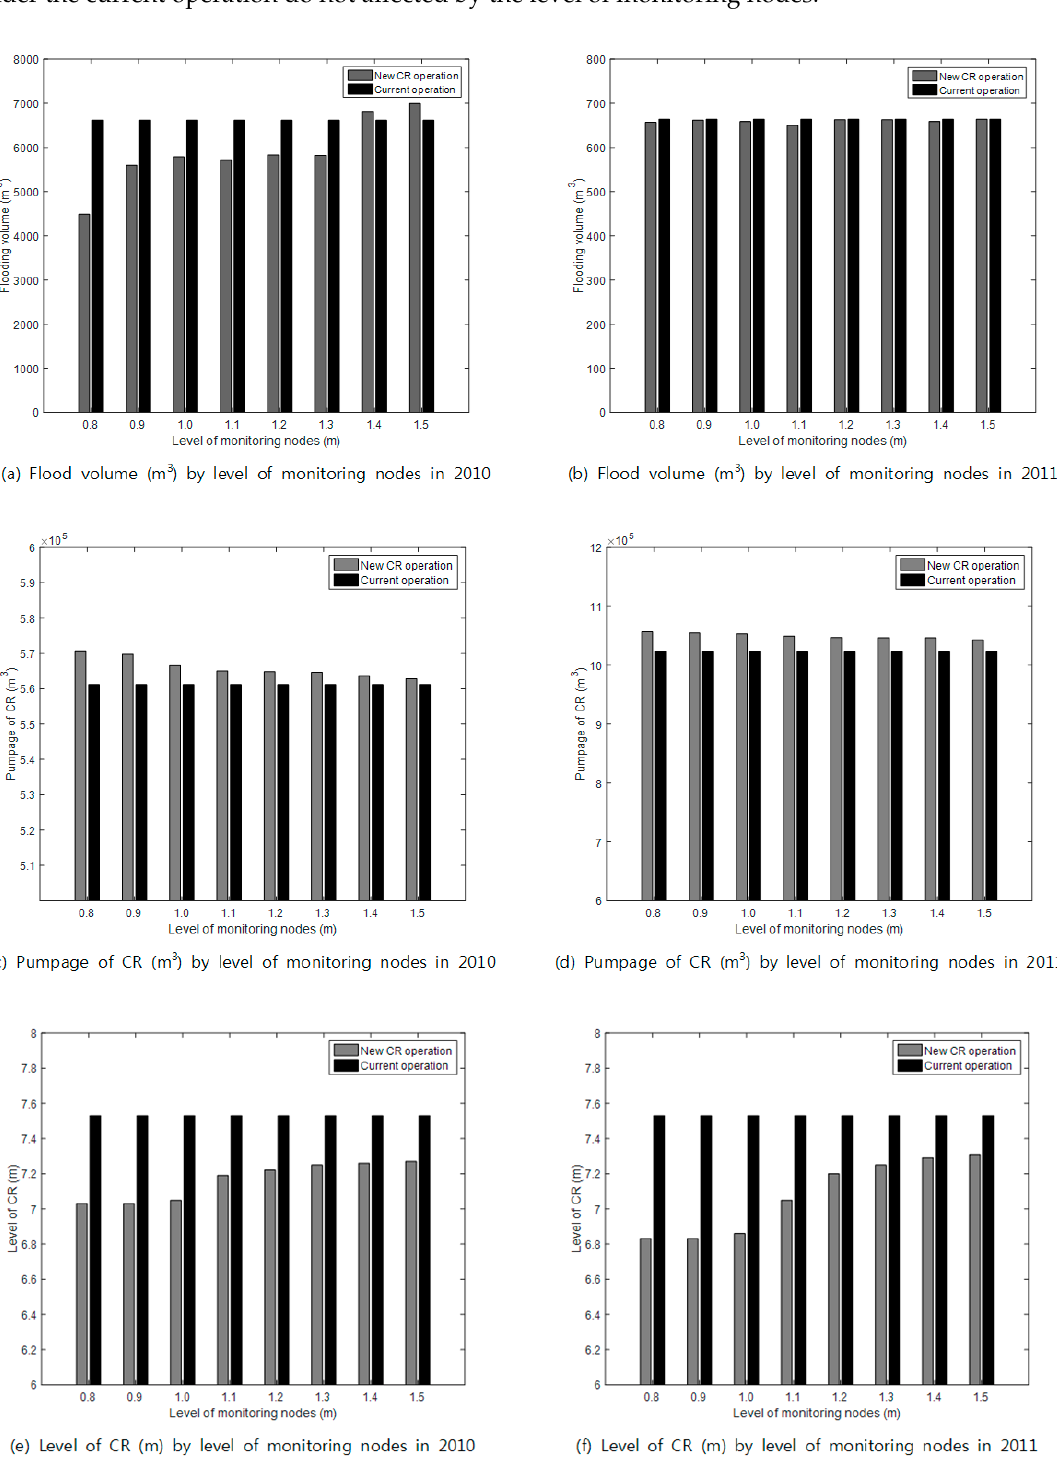
Figure 12. Results of new centralized reservoir operation.